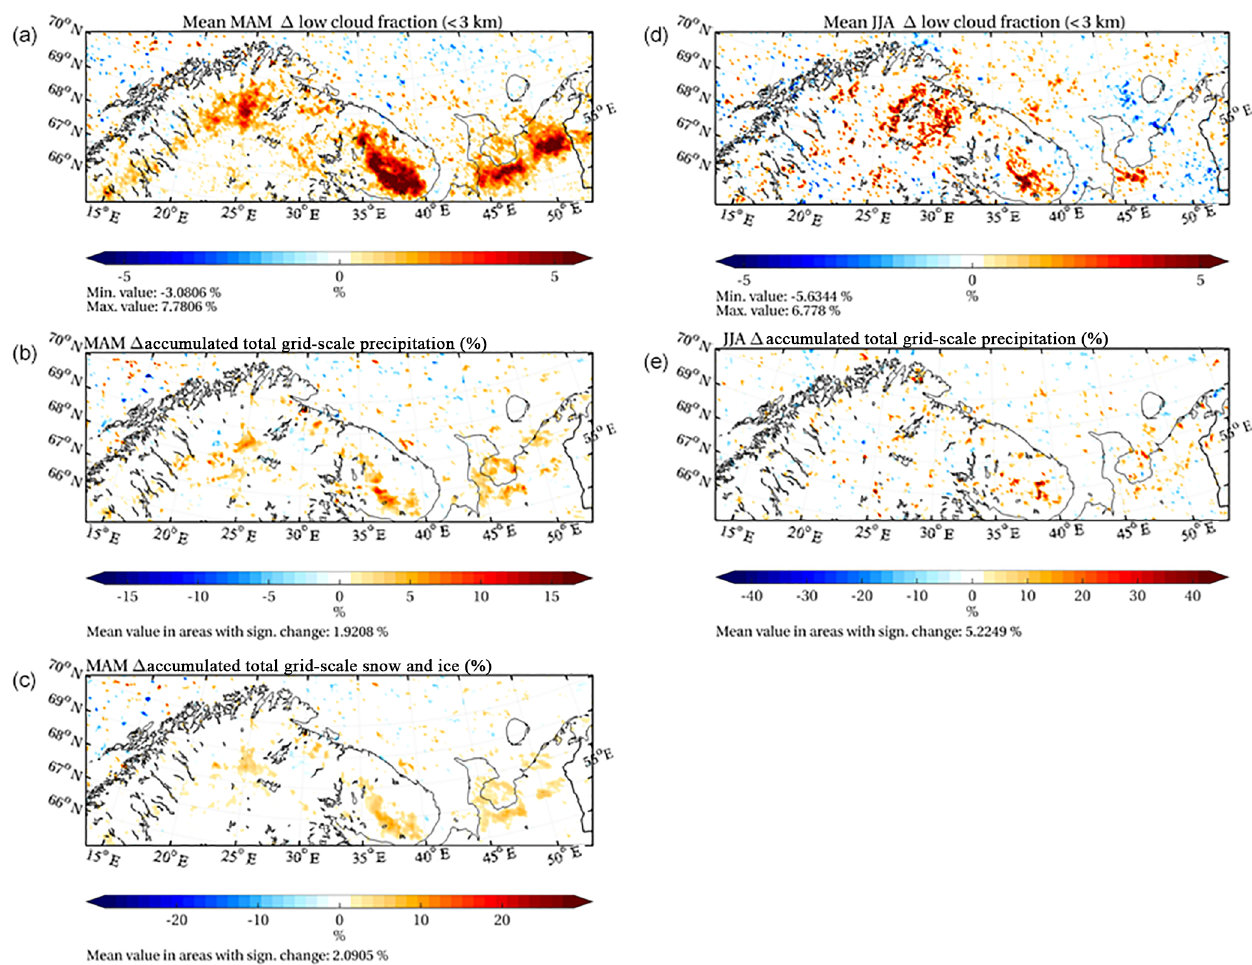
Figure 6. Effects of increased shrub cover (Veg0K–RefVeg) on low-level (<3km) cloud cover fraction (a, d) , relative change in accumulated seasonal precipitation (b, e) , and spring season snow and ice precipitation (c) . Only showing significant changes at the 95% confidence level, as in Fig. 4. For precipitation, significance tests are conducted on daily values of accumulated precipitation rather than 3-hourly values. Mean over spring seasons in the left column and summer seasons in the right column. Note that scales differ among